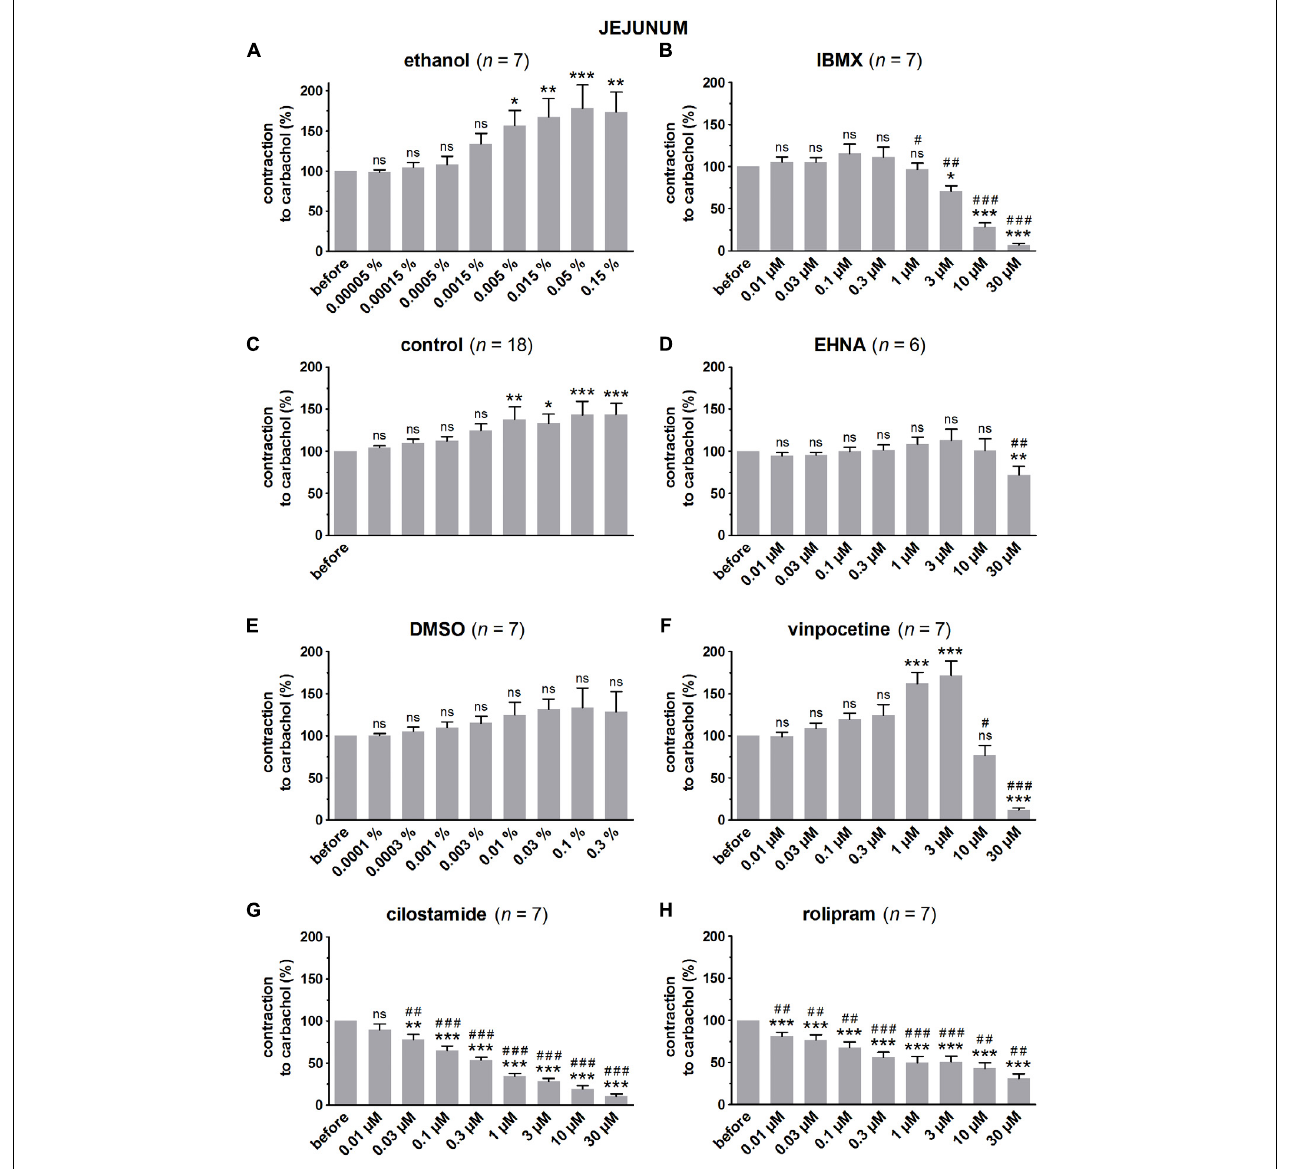
FIGURE 2 | Influence of increasing concentrations (0.01–30 µ M) of the PDE inhibitors IBMX (B) , EHNA (D) , vinpocetine (F) , cilostamide (G) and rolipram (H) , and the solvents ethanol (A) and DMSO (E) on submaximal carbachol-induced contractions (0.05 µ M) in murine jejunum circular smooth muscle strips. Parallel time controls not receiving PDE inhibitor or solvent are shown in (C) . Contractions in the presence of increasing concentrations of the PDE inhibitor are expressed as percentage of the reference contraction before addition of the PDE inhibitor. Means ± SEM; ns not significant, ∗ P < 0.05, ∗∗ P < 0.01, ∗∗∗ P < 0.001 versus reference before (repeated measures ANOVA with Bonferroni corrected t -test) and # P < 0.05, ## P < 0.01, ### P < 0.001 versus corresponding control (unpaired t